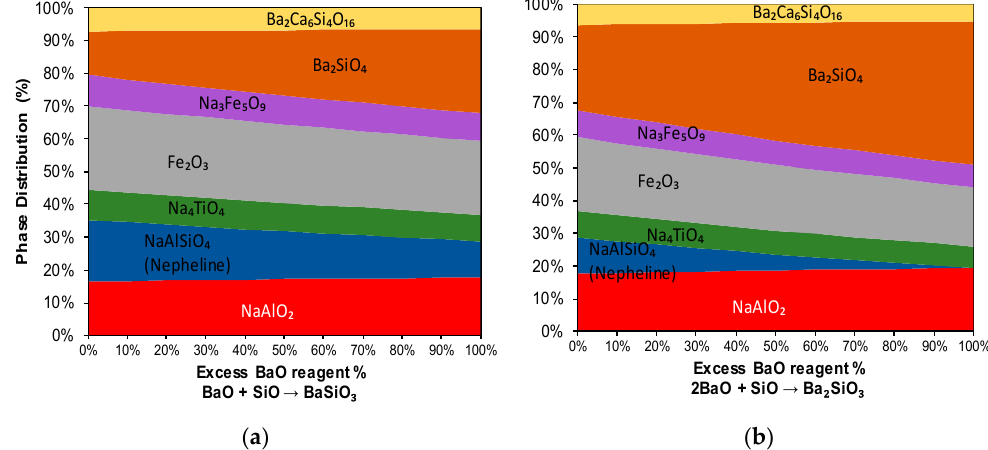
Figure 18. Thermodynamic predictions of sinter phase formation ( a ) when monobarium silicate is expected or ( b ) when dibarium silicate is expected at excess of BaO additions at 50% excess soda, 900 °C for 2 h.